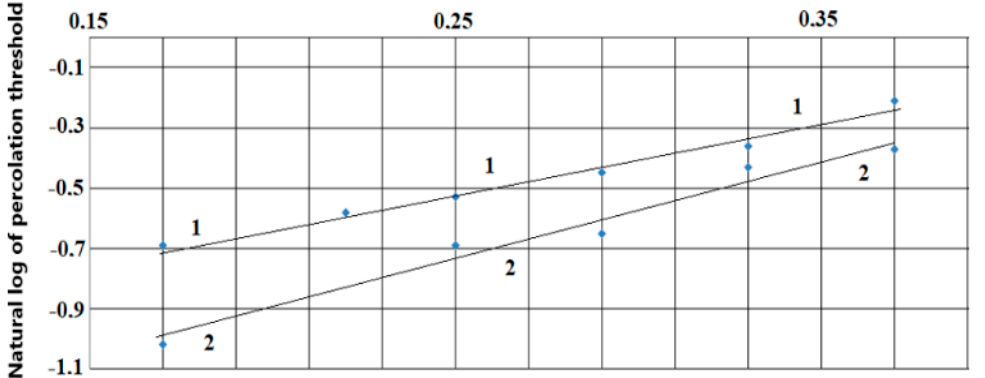
Figure 8. Dependency of natural log percolation threshold value ( lnP ( x )) on planar accidental structures from the reciprocal of density (1/ x ).